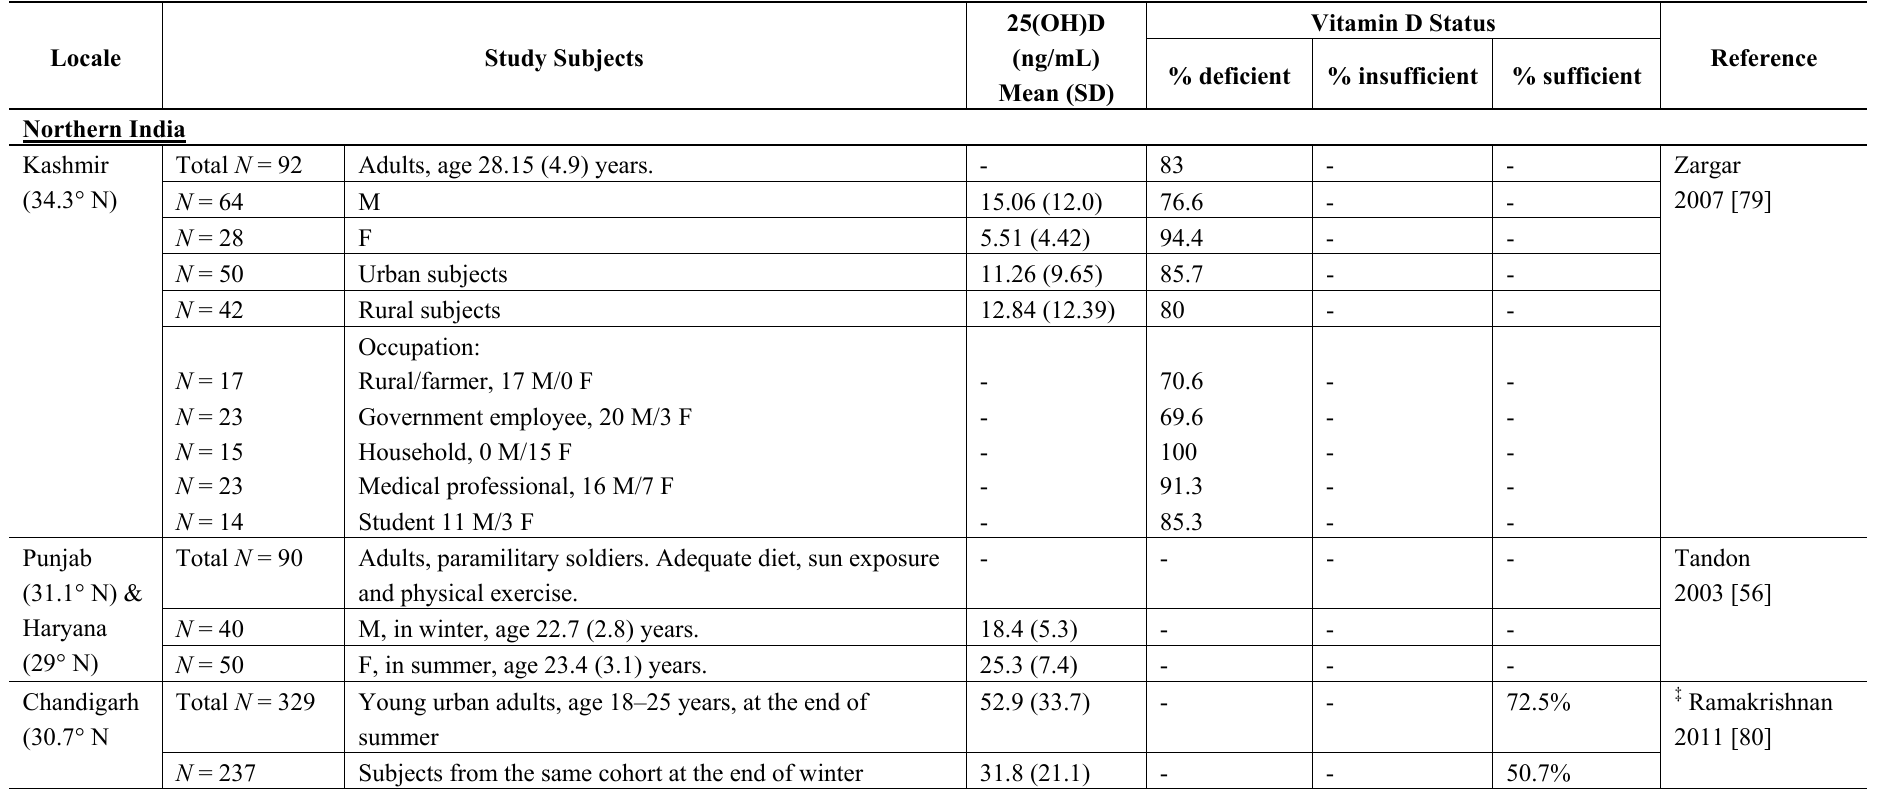
Table 1. Vitamin D status of ostensibly healthy Indians. All 25(OH)D values have been shown in ng/mL. To convert from nM to ng/mL, nM values were divided by (2.5). Vitamin D deficiency is defined as 25(OH)D < 20 ng/mL, insufficiency as 20–29 ng/mL and sufficiency